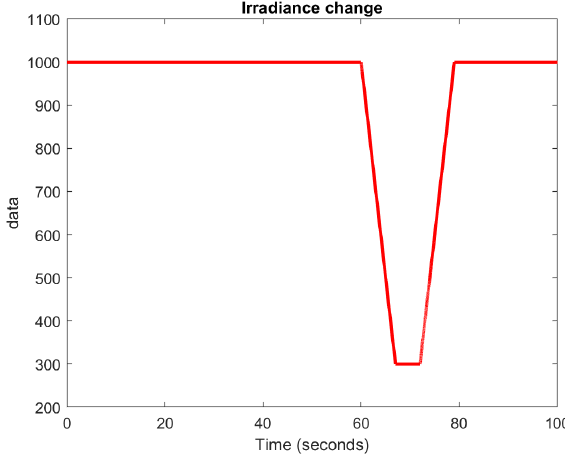
Figure 20. Simulation 8 irradiance profile. Figure 20 . Simulation 8 irradiance profile. Figure 20 . Simulation 8 irradiance profile.